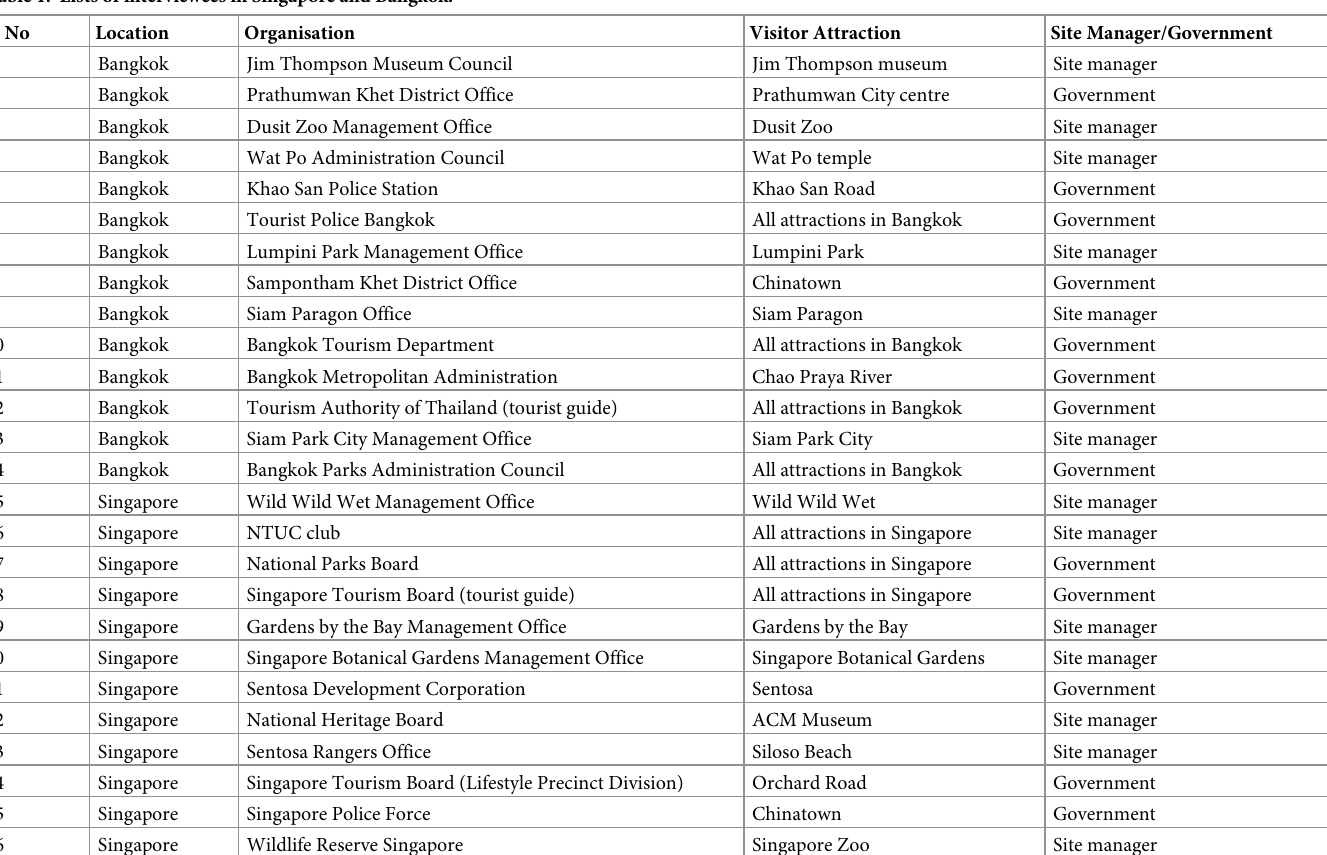
Table 1. Lists of interviewees in Singapore and